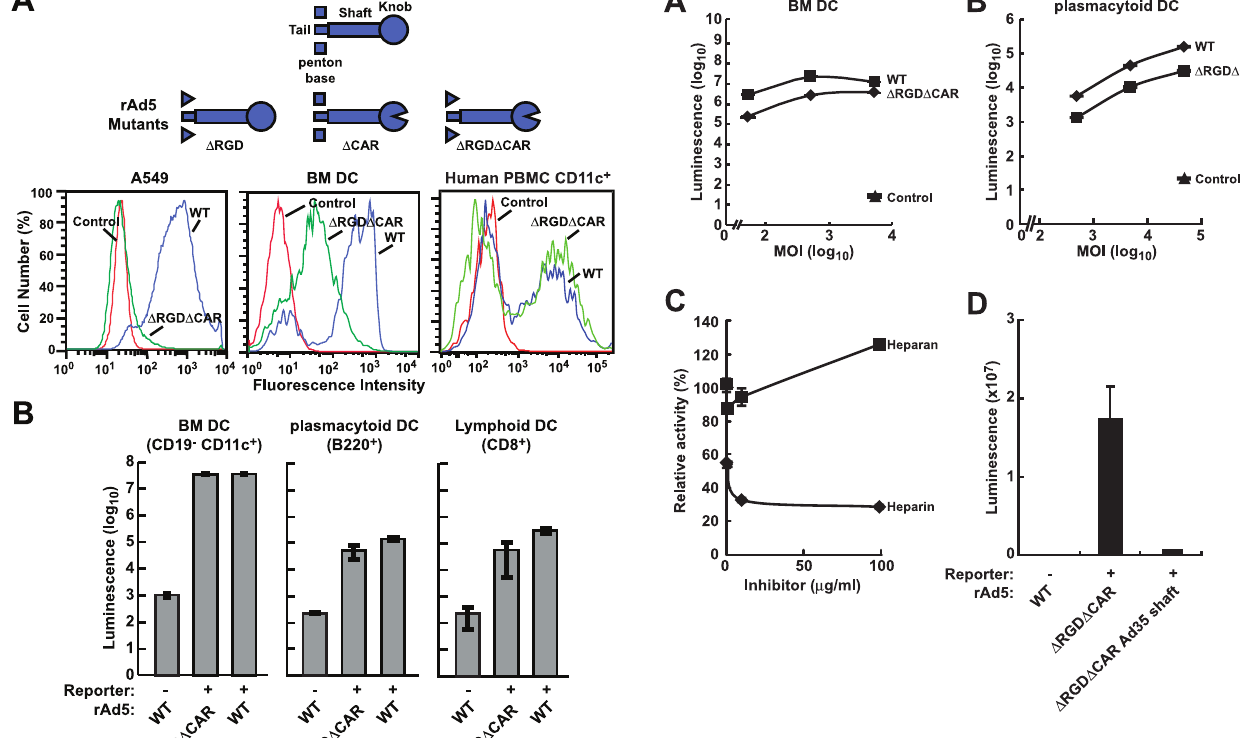
Figure 2. Transduction Efficiencies of WT and Mutant rAd Vectors in DCs and Sensitivity of Mutant Adenoviral Vector Infectivity to Heparin Inhibition Murine BM DCs (A) or human plasmacytoid DCs (B) isolated from PBMCs using MACS magnetic cell separation (Miltenyi Biotech Inc) were transfected with the indicated viral vectors expressing luciferase and luciferase expression were analyzed at 24 h postinfection. The control consisted of cells mock-transfected with culture medium. The data are the representatives of three independent transfections. (C) Murine BM DCs were preincubated with heparin or heparan sulfate for 30 min at room temperature and then transfected with the CAR (cid:2) RGD (cid:2) rAd at 100 viral particles per cell, and relative luciferase activity was evaluated in a dose-response fashion to heparin or heparan sulfate at 24 h postinfection. The data shown are representative of three independent experiments. (D) BM-derived DCs were transduced with the CAR (cid:2) RGD (cid:2) rAd or CAR (cid:2) RGD (cid:2) rAd with Ad35 shaft at 3,000 viral particles per cell, and luciferase expression was analyzed at 24 h postinfection.